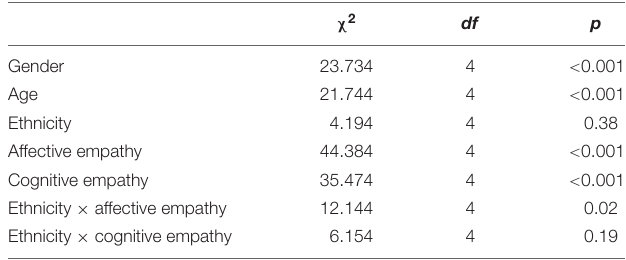
TABLE 4 | The omnibus Chi-square